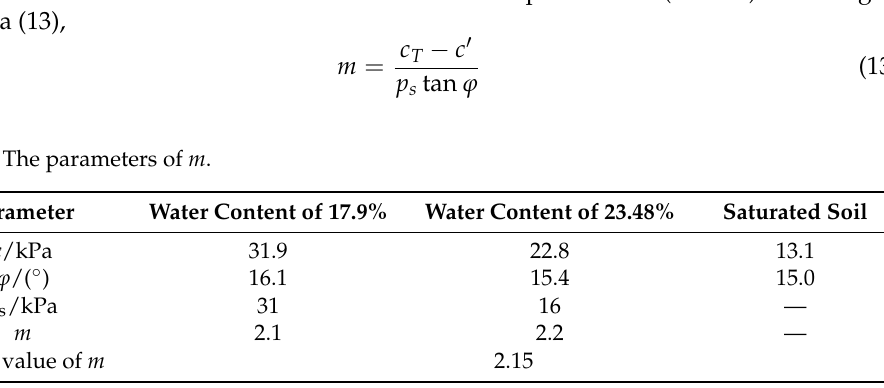
Table 1. The parameters of m .